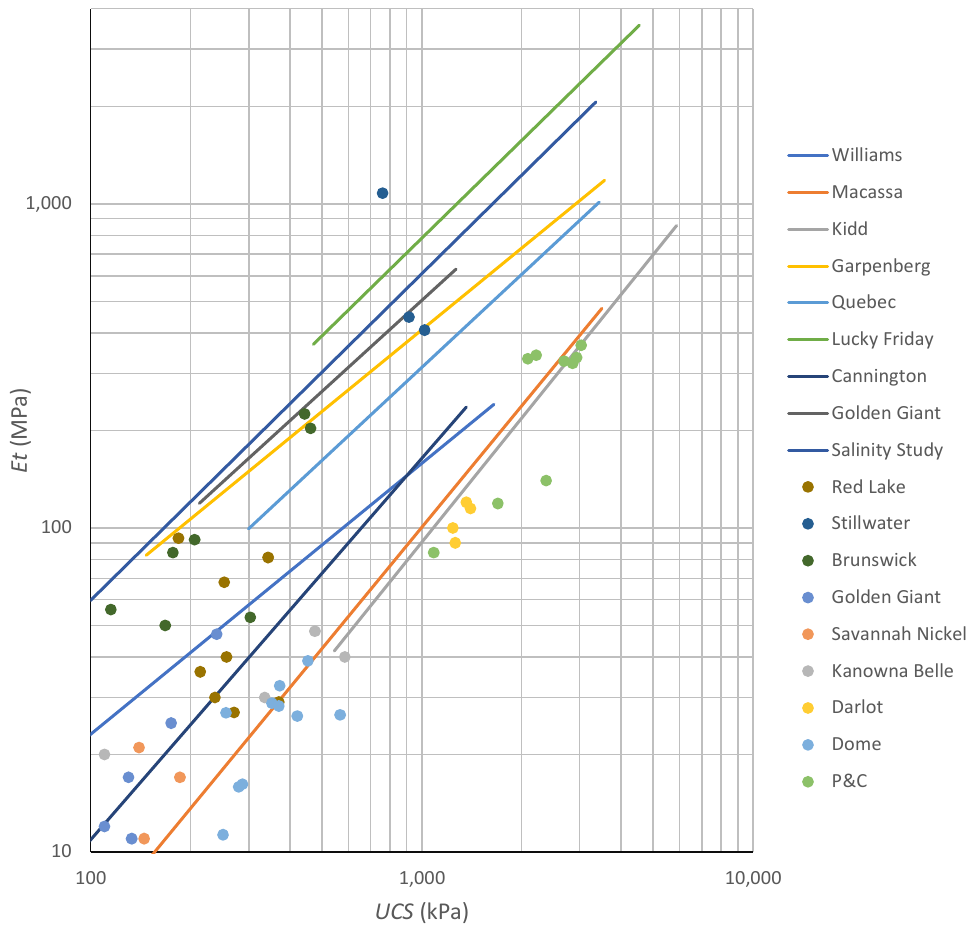
Figure 11. Relationship between E t and UCS : summarized results (the salinity study markers may be an order of magnitude too high, see footnote of Table 2). Table 2. Summary of E t and UCS datasets, and fitting parameters for E t = const UCS exp where the modulus is in MPa and the strength is in kPa; n is the number of datapoints in the dataset; the strength range is UCS min to UCS max ; R 2 is the coefficient of determination; e is void ratio; G s is specific gravity of tailings; % sand is the fraction of tailings (and any blended aggregates) greater than 0.075 mm; values may be approximated from the original publications and the reader should refer to the original if detailed information is required. Regression analysis is performed using MS Excel for power functions. The abbreviations used for binder type are Portland Cement (PC), fly ash (FA), and ground granulated blast furnace slag (Slag) and their relative proportions when blended. The regression analysis parameters and other mix design information are not reported for small datasets nor datasets with poor coefficients of determination. For the remaining datasets, mix design parameters unavailable from the original article are indicated using n/a.